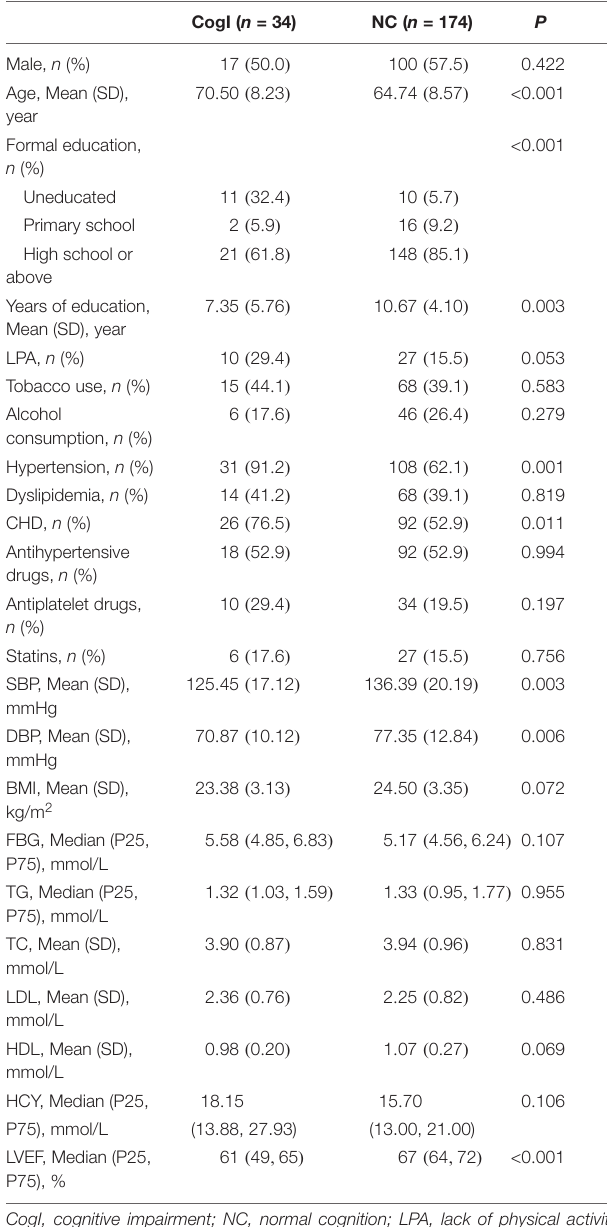
TABLE 2 | Differences in covariates between the cognitive impairment group and the normal cognition group in the total